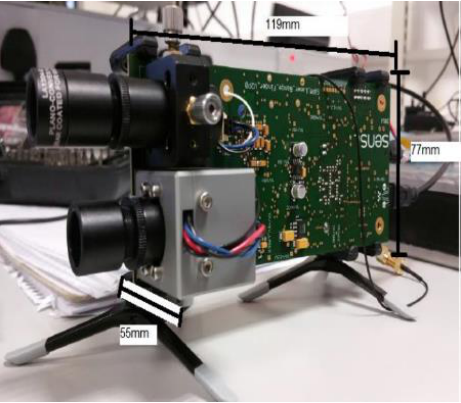
Figure 7. Long-range LiDAR prototype brought to the project.